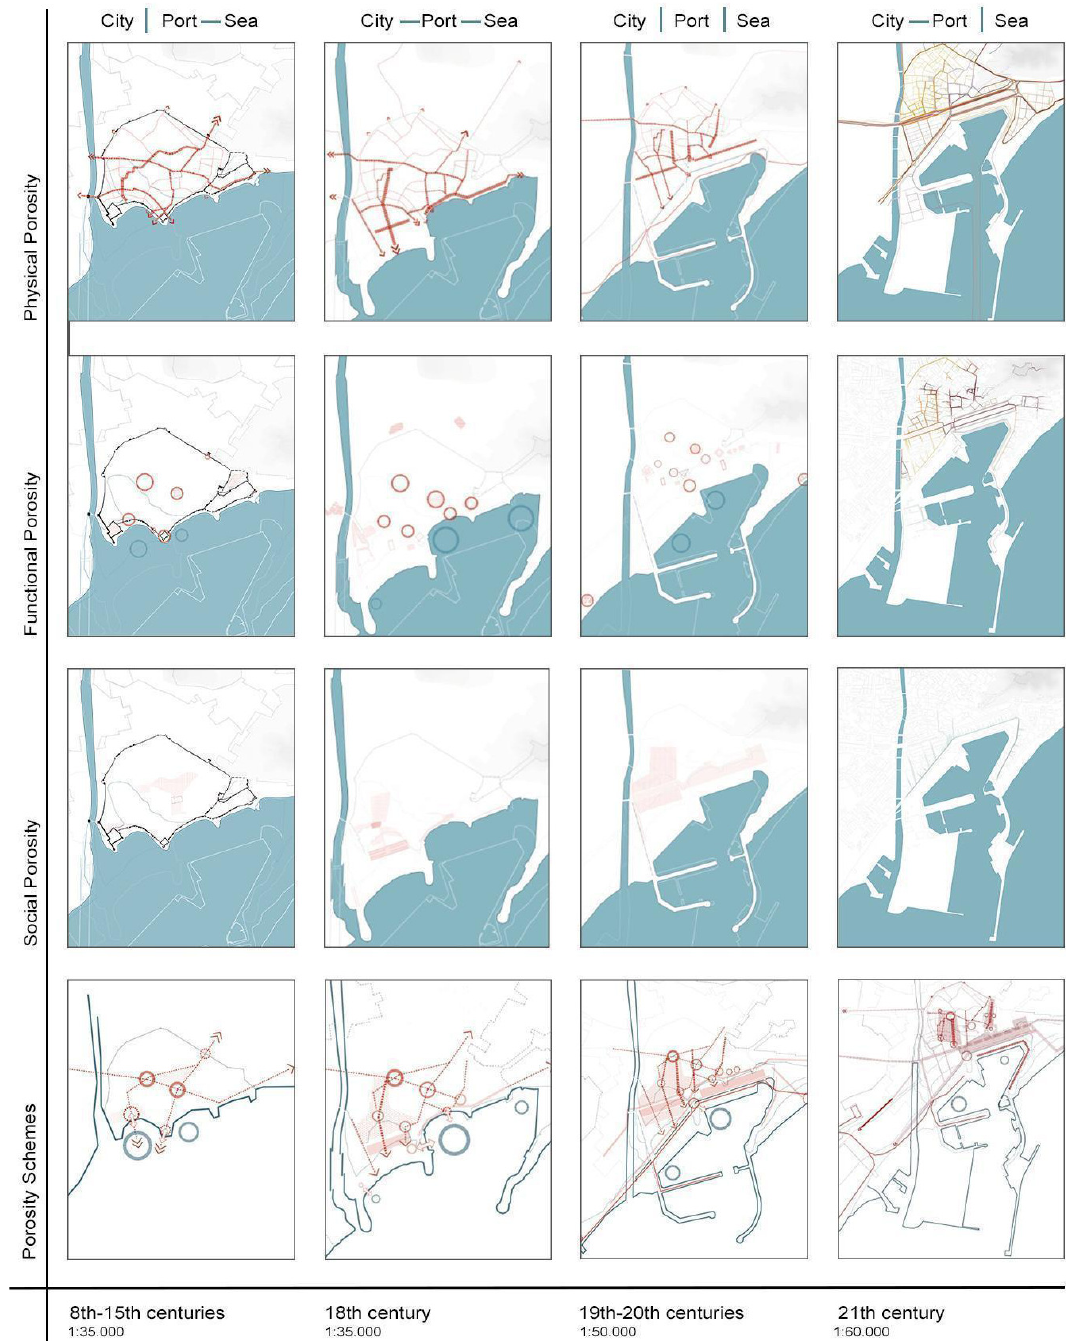
Figure 8. Joint reading of the port and the city throughout history; Physical, functional, and social analysis. Source: María J. Andrade